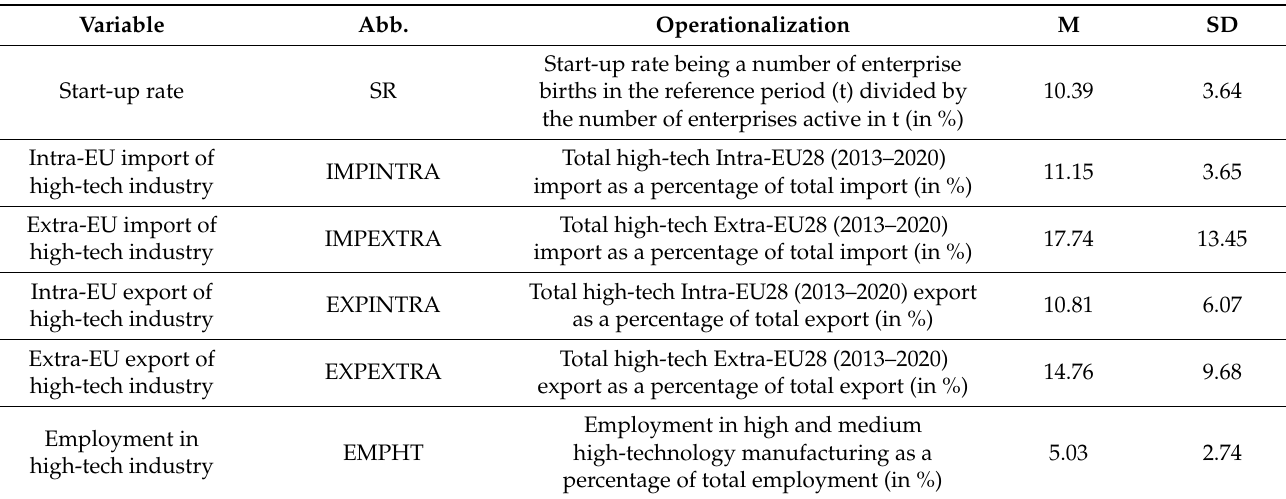
Table 1. List of variables, their abbreviations and descriptive statistics for all analysed countries in years 2009–2018. Variable